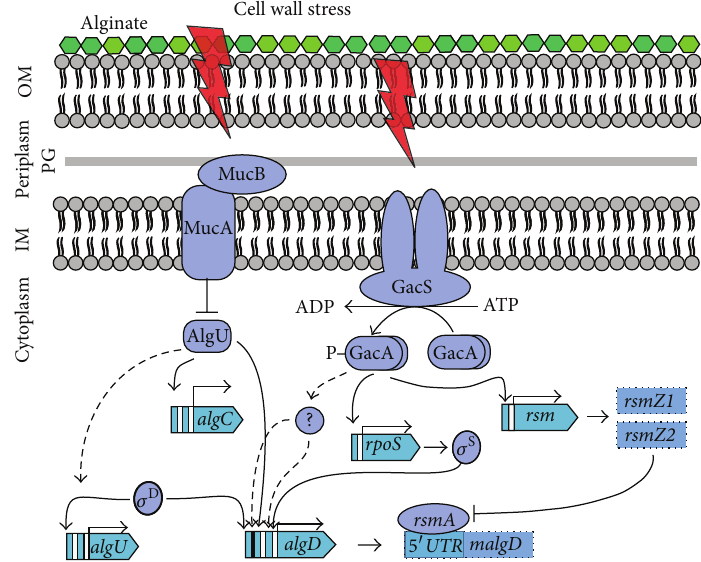
Figure 5: Regulation of alginate biosynthetic genes in A. vinelandii (modified according to reference [40]). Promoters are indicated as banners; mRNAs are indicated as dotted boxes; solid lines indicate the reported mechanism of regulation, and dashed lines indicate unknown mechanism of gene regulation; arrows indicate positive regulation and T-shaped bars indicate negative regulation. OM: outer membrane; PG: peptidoglycan; IM: inner membrane. See text for a more detailed